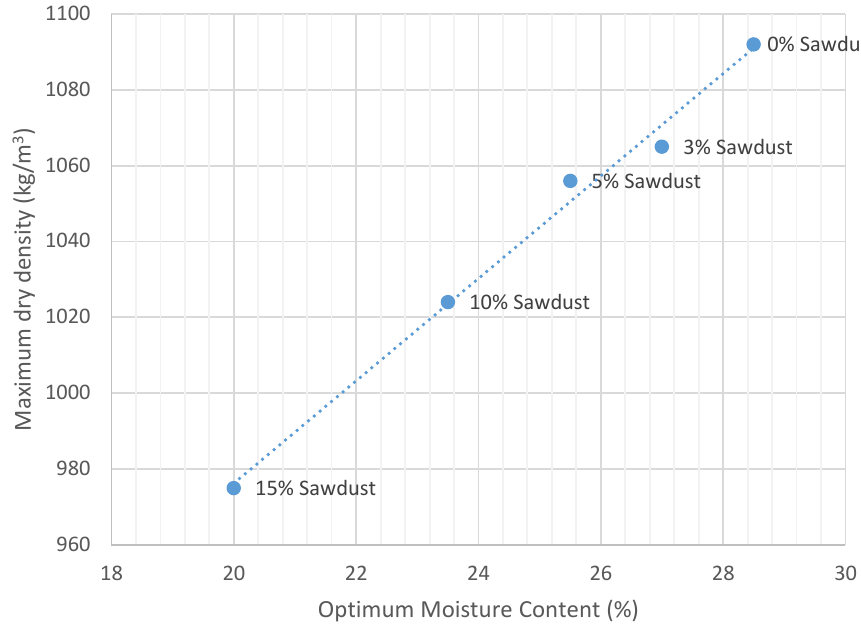
Figure 5. Trend of variation of compaction results for 0%, 3%, 5%, 10% and 15% sawdust.